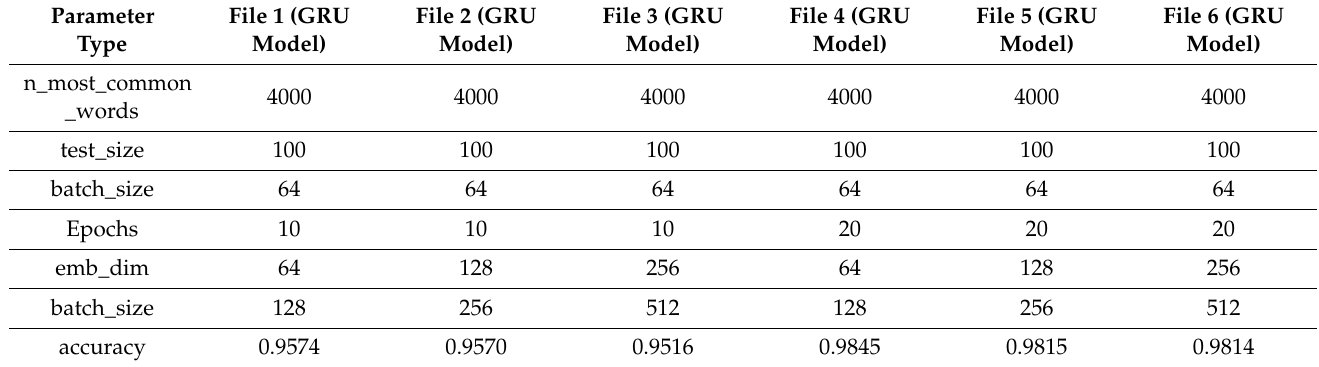
Table 4. Chatbot program test results (Files 1 to 6).